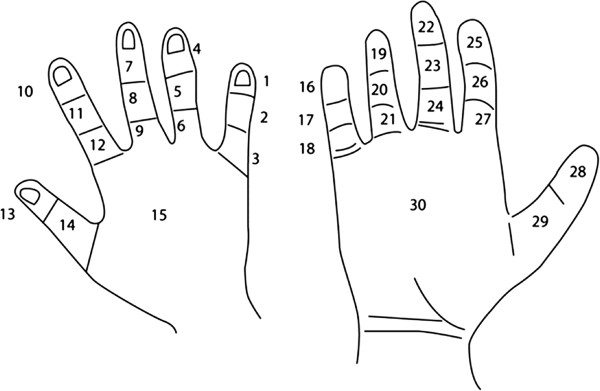
Classification of anatomical regions of hand.